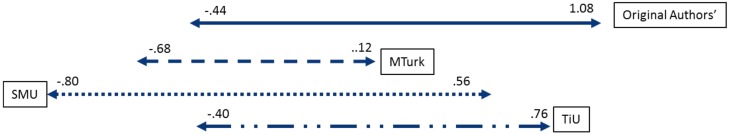
After writing about comfort food, securely attached participants who underwent a belongingness threat should not differ in loneliness level from their counterparts in the no threat condition (null hypothesis).